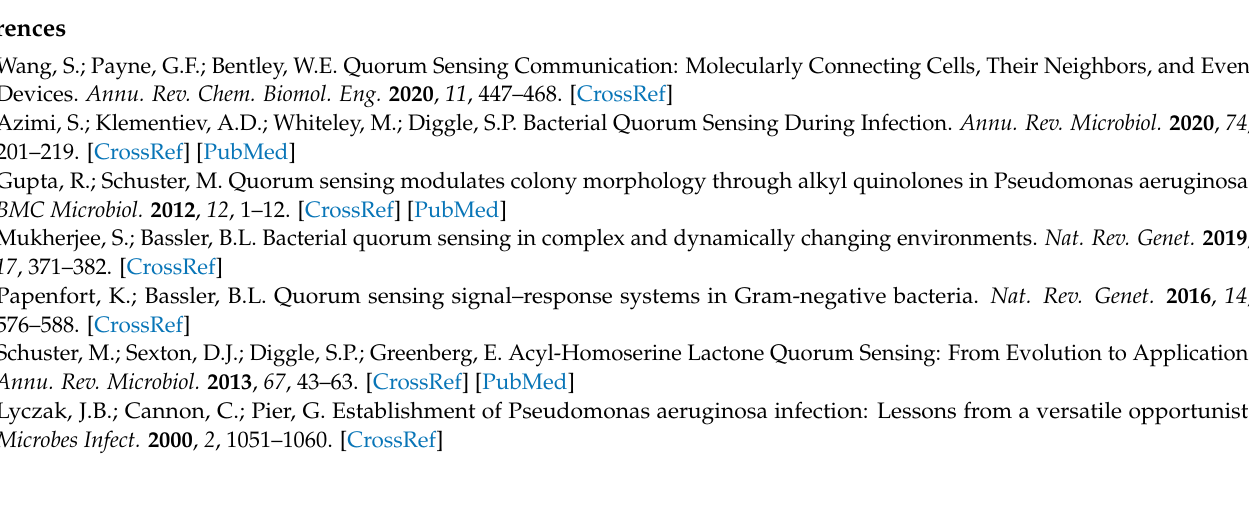
corresponding to data in Figure 1, Figure S2: Effect of artificial sweeteners on K802NR growth, Figure S3: Response of PAO-JP2 (pKD- rhlA ) reporter strain to different concentrations of artificial Table S1: Profile of SS